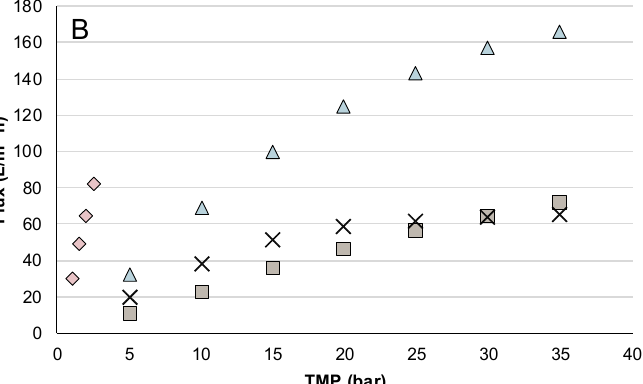
Figure 2. Permeate fluxes of the nine membranes tested during the parametric studies at different TMPs for ( A ) membranes NanoPro B-4021, NanoPro B-4022, NF090801, NADIR NP030 P, and SelRO MPF-34, and ( B ) membranes SelRO MPF-36, NADIR NP010 P, UF-pHt GR95PP, and MexFil MP025 dNF40.